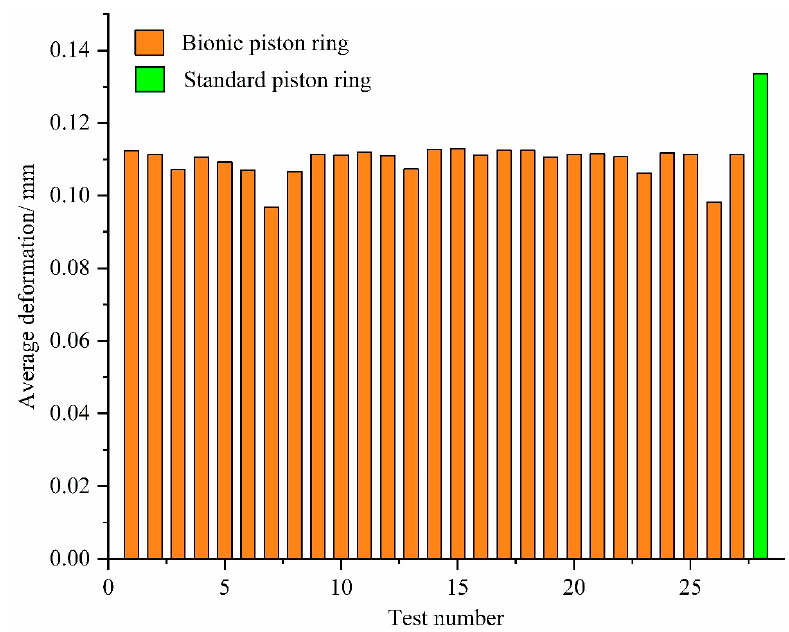
Figure 7. Average deformation of the piston ring group.